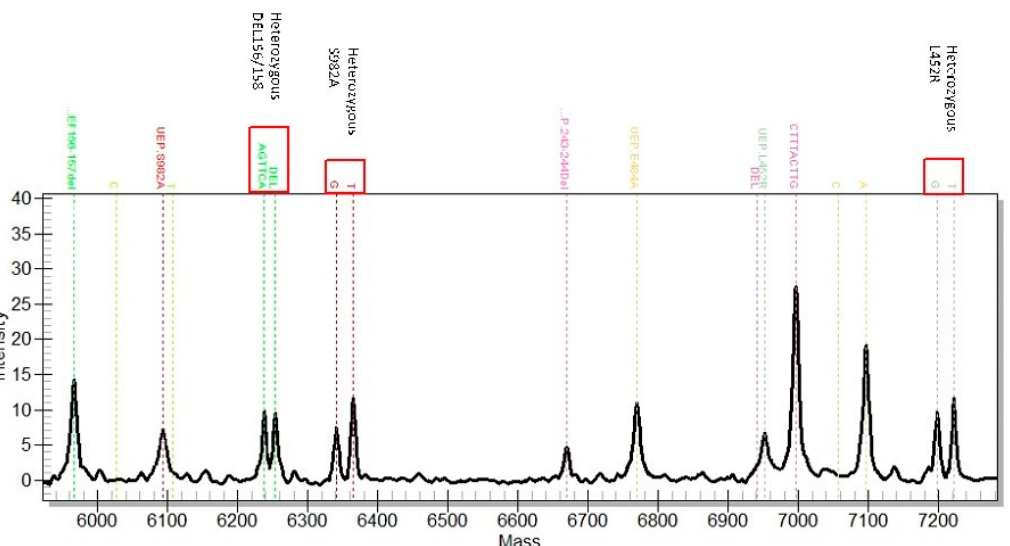
Figure 4. The mass spectrum of SARS-CoV-2 spike genes from wastewater specimen. Two SARS- CoV-2 variants were identified. Heterozygous peaks of three targets are shown: DEL156/158, S982A, and L452R. DEL156/158 and L452R are the specific markers for Delta, and S982A and DEL69/70 are the specific markers for the Alpha variant. UEP—unextended primer.